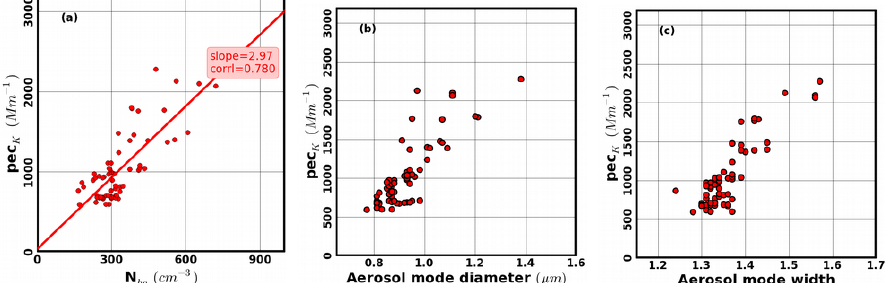
Figure 8. The relationship between the particle extinction coefficient (pec K ) directly measured by the DF20 + , and the accumulation mode parameters derived from the WELAS: (a) aerosol mode number concentration ( N ha ) (with the linear correlation in red), (b) mode diameter and (c) mode width. Measurements are made during the pre-fog mist events of November 2011.